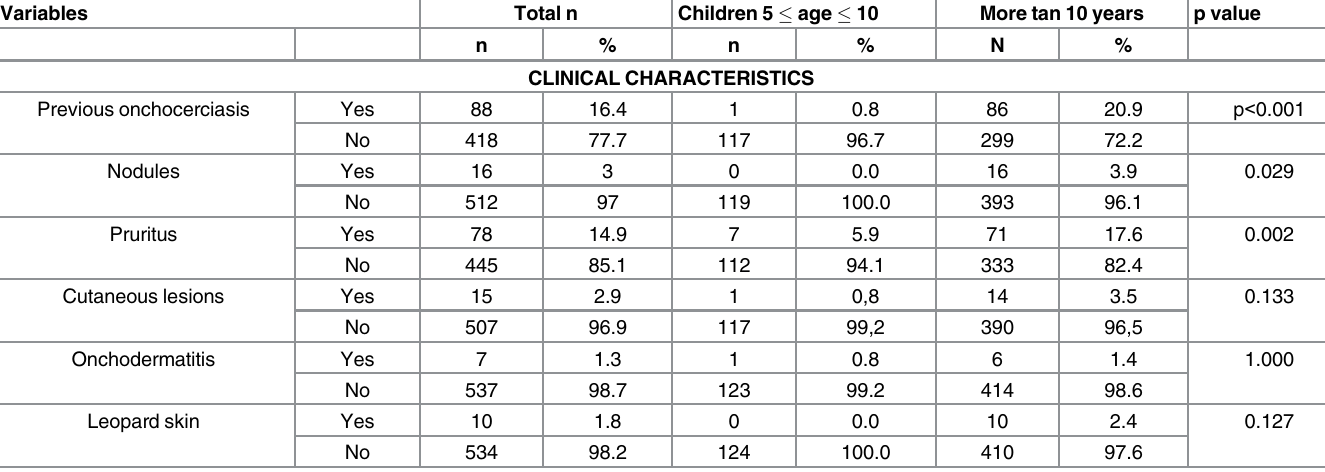
Table 2. Clinical characteristics of onchocerciasis of the study population, by age Bioko Island, Equatorial Guinea, January 2014. Variables Total n Children 5 (cid:1) age (cid:1)